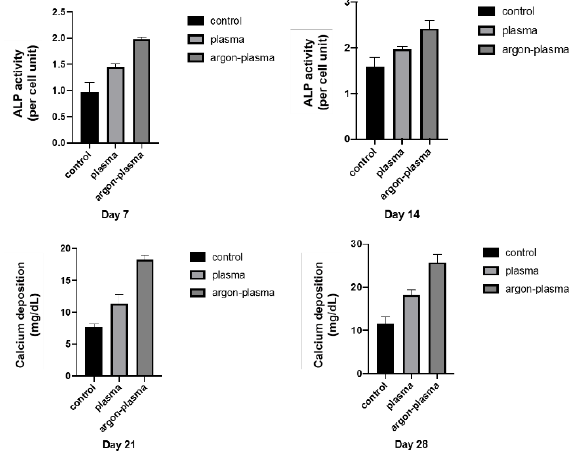
Figure 6. Alkaline phosphatase (ALP) expression in bone marrow cells at days 7 and 14, after the start of culture, was significantly higher on the material surface of the argon plasma-treated group, among all three groups. The amount of calcium deposited on the material surface at days 21 and 28 after the culture incubation, was significantly the highest for the argon plasma-treated group, among all three